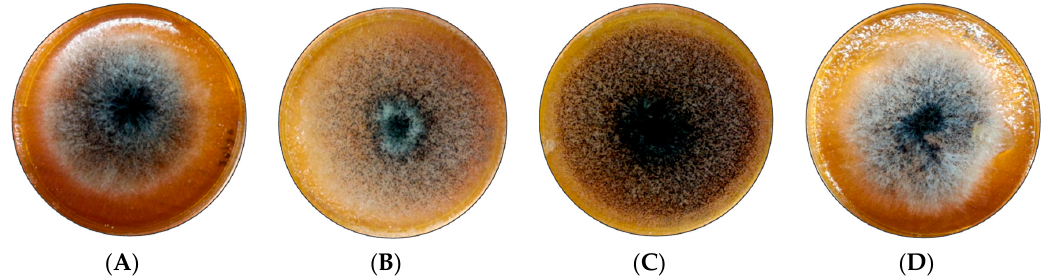
Figure 2. Morphological aspects of A. carbonarius S402 in Synthetic Grape Medium (SGM), at 28 °C for 4 days. ( A ): Control, ( B ) Cumin phenolic extracts, ( C ) Bay leaves phenolic extracts, and ( D ): mint EO at 1 µL mL − 1